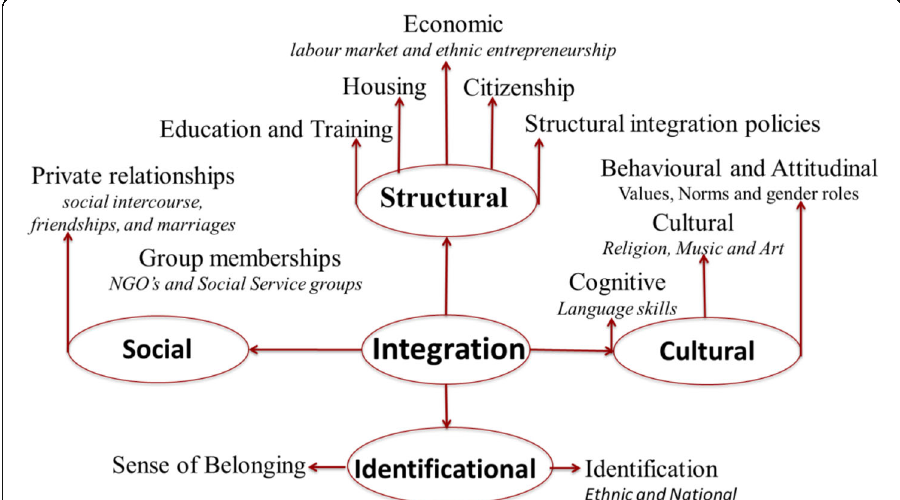
Fig. 1 Four dimensions of immigrant integration and related aspects. Source: Heckmann et al.